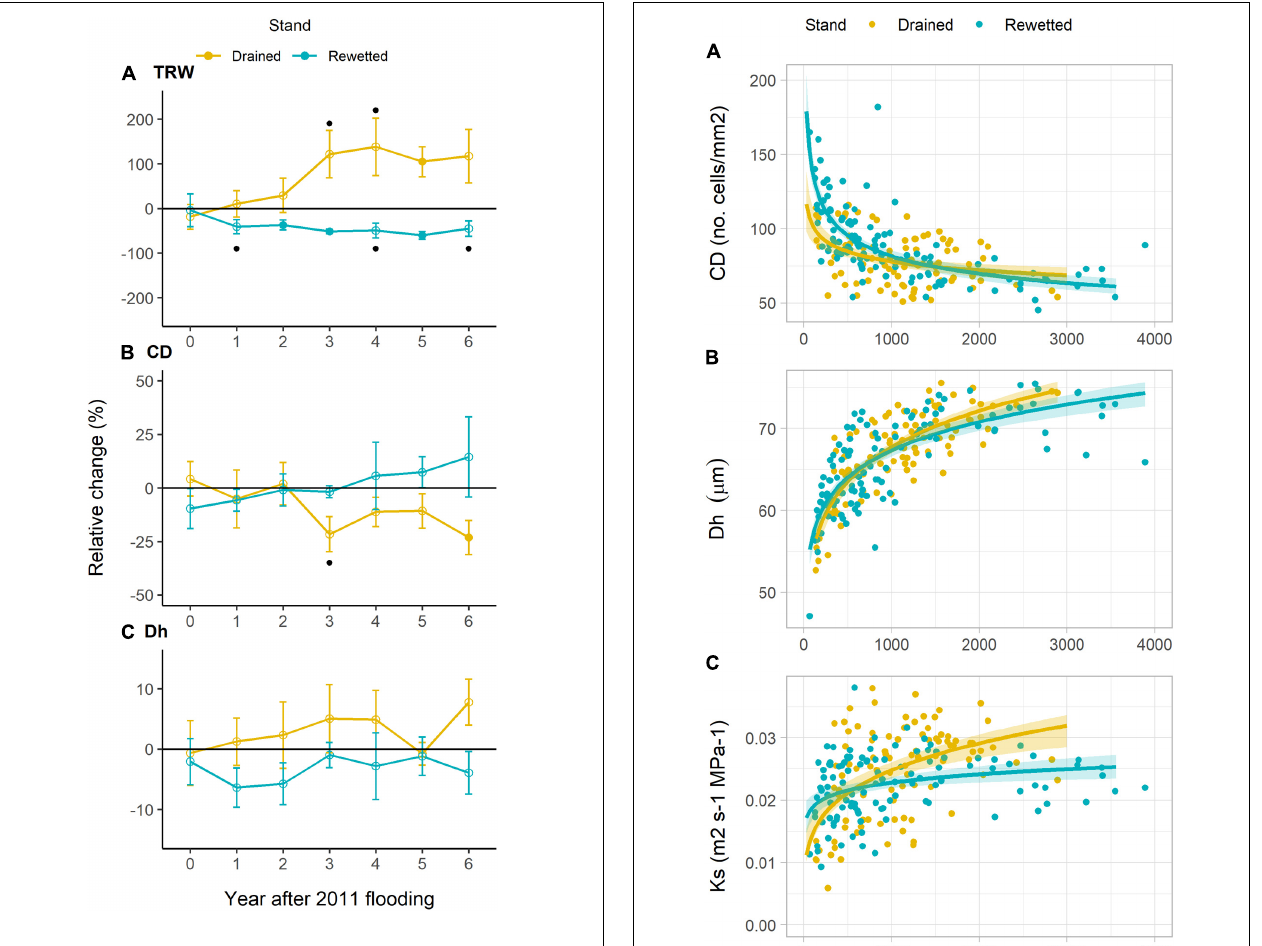
FIGURE 4 | Relative change (means ± SE) of (A) tree-ring width (TRW), (B) vessel density (CD), and (C) hydraulically weighted mean vessel diameter (Dh) after 2011 flooding with respect to the reference (mean of 6 years prior to 2011 for each stand) in both stands. Year 0 corresponds to 2011. Empty circles represent non-significant change values ( P ≥ 0.10), filled circles represent significant changes with respect to the reference ( P < 0.05). Dots indicate marginally significant changes (0.05 ≤ P < 0.10).